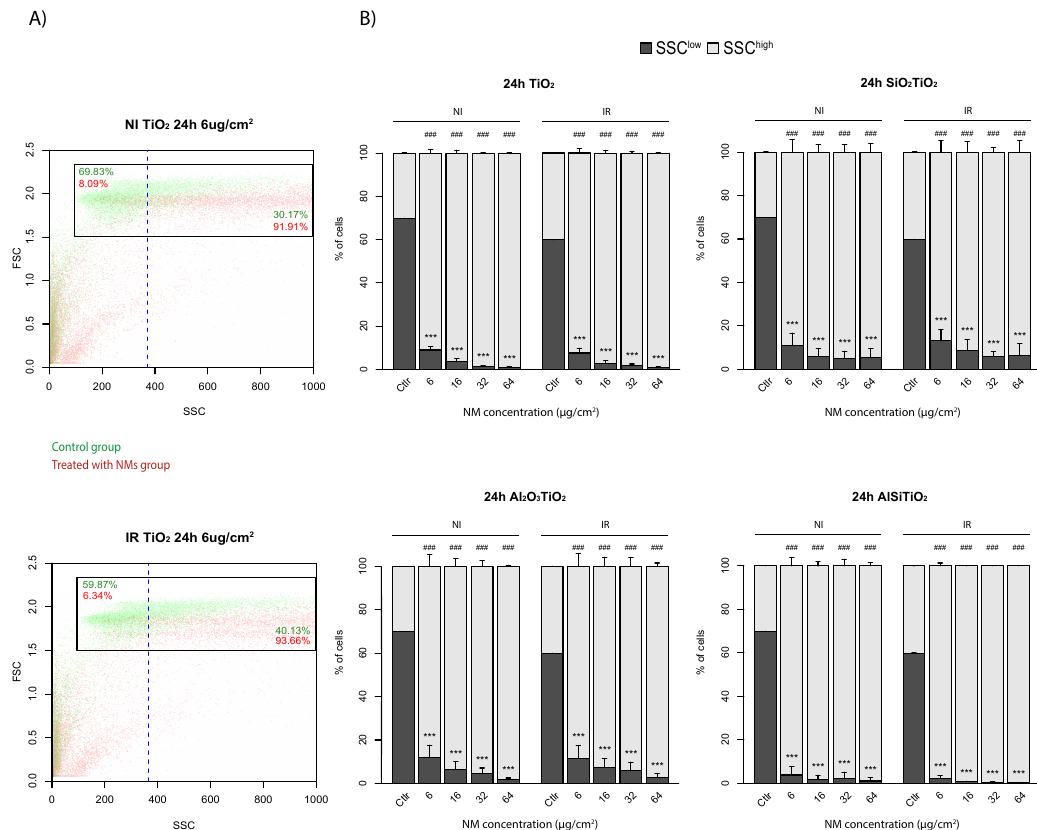
Figure 1. Internalization of nanomaterials (NMs) into 16HBE14o- cells. Cells are platted in 24 wells plates at 4.5 × 10 4 cells per well, and maintained in control conditions (Ctlr), or in the presence of 6, 16, 32 or 64 µ g / cm 2 of the di ff erent type of TiO 2 . ( A) Flow cytometry are performed 24 h later, and internalization is measured by the increase of SSC for TiO 2 , SiO 2 TiO 2 , Al 2 O 3 TiO 2 and AlSiTiO 2 . A threshold is defined at 70% for non-irradiated cells, and 60% for irradiated cells regarding the pattern of FSC / SSC for the control groups, and ( B ) the results are reported for each type of NMs. (means ± S.E.M., n = 3, *** p < 0.001 (Welch t -test), as compared to the percentage of SSC low of the control group, ### p < 0.001 (Welch t -test), as compared to the percentage of SSC high of the control